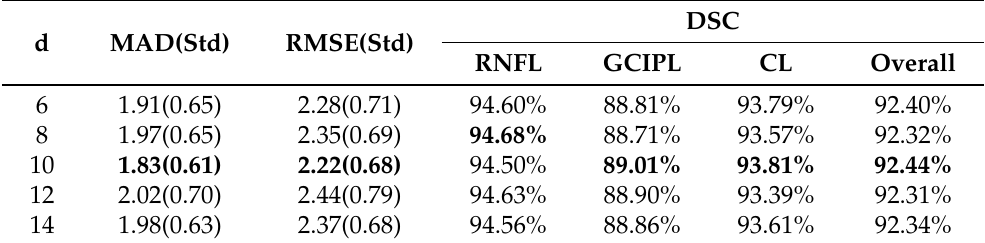
Table 3. Quantitative comparison results of modifying the hyperparameter d of the boundary area loss function.